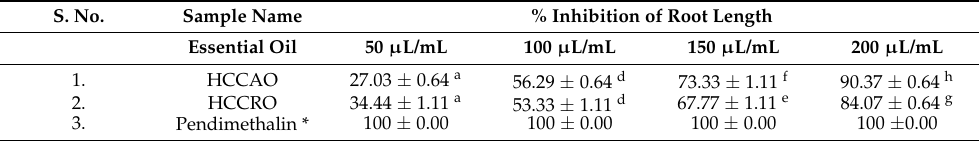
Table 10. Mean percent inhibition of root length of HCCAO and HCCRO.